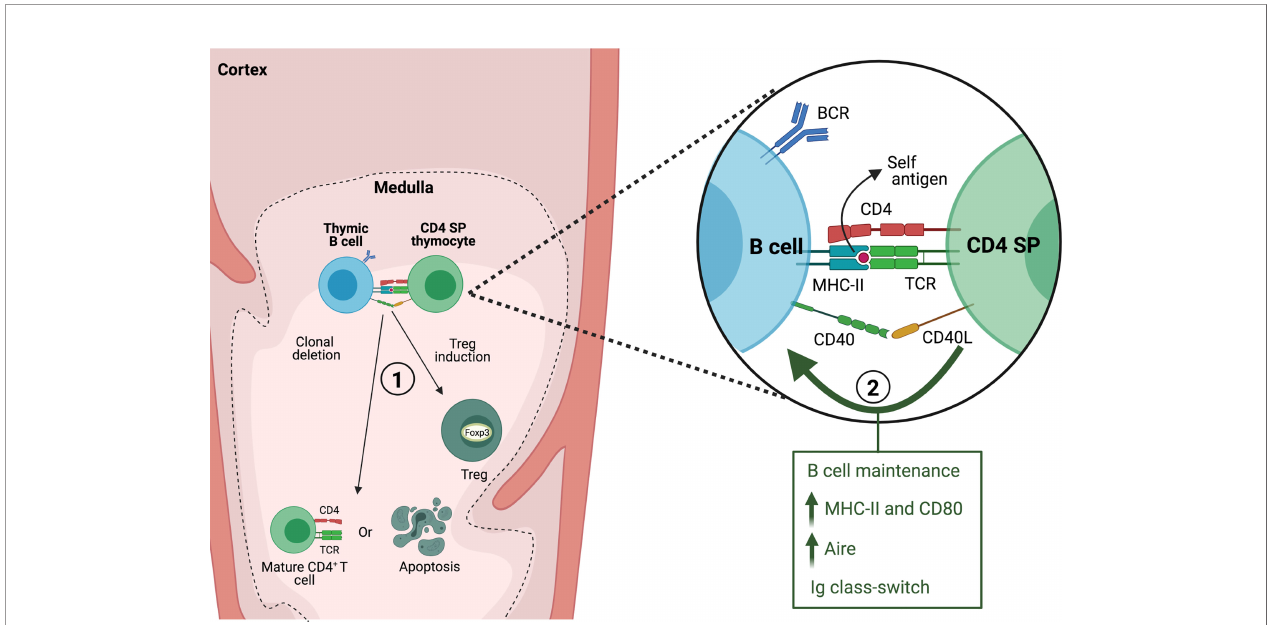
FIGURE 2 | Interaction between thymic B cells and CD4 SP thymocytes. In the thymic medulla, B cells present self-antigen to CD4 SP thymocytes through MHC-II and engagement of CD40/CD40L. The interaction between both cells leads to 1) clonal deletion or generation of thymic regulatory T cells (Treg) and 2) is required for maintaining normal thymic B cell numbers and acquisition of a thymic resident B cell